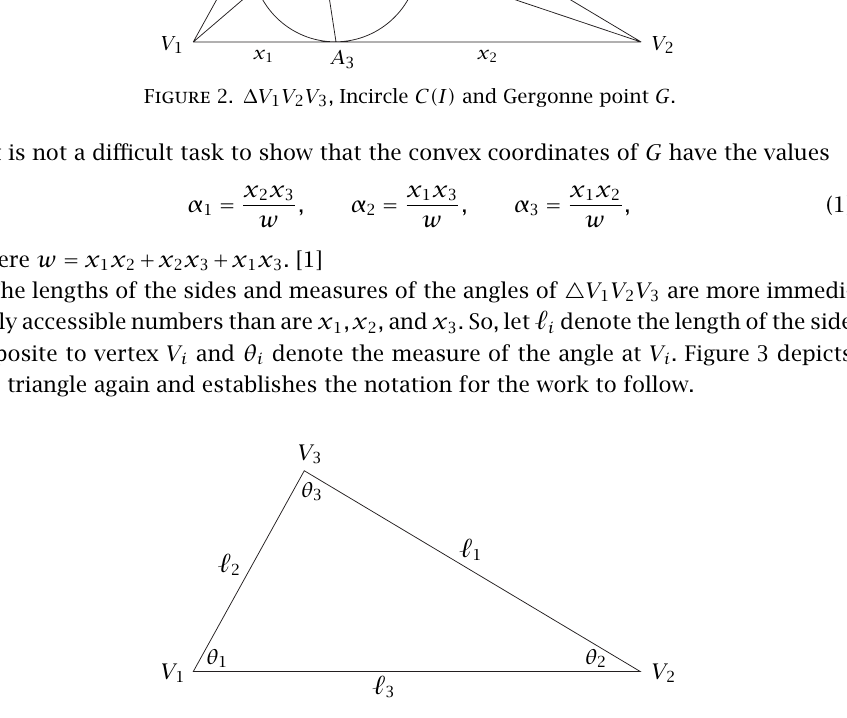
Figure 3 . ∆ V 1 V 2 V 3 with sides and angles